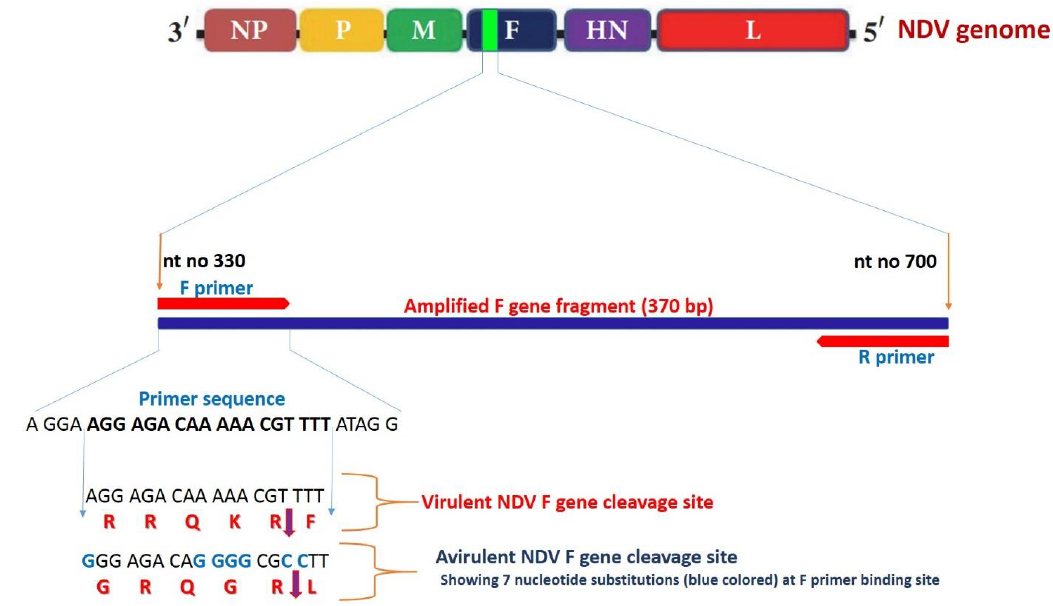
Figure 1. The diagram illustrates RT-PCR targeting 370 bp F gene fragment (nt no. 330–700) with F primer containing a characteristic virulent Newcastle disease virus (NDV) F gene cleavage site (nt no. 334–351). The low-virulent NDV cleavage site showed seven nucleotide substitutions (guanine instead of adenine at positions 334, 342, 343, 344, and 345 and cytosine instead of thiamine at positions 348 and 349) when compared to the forward primer nucleotide sequence, making it difficult to amplify the target fragment from low-virulent NDV. Table 2. Details of the two sets of primers and probes used for amplification of the NDV gene